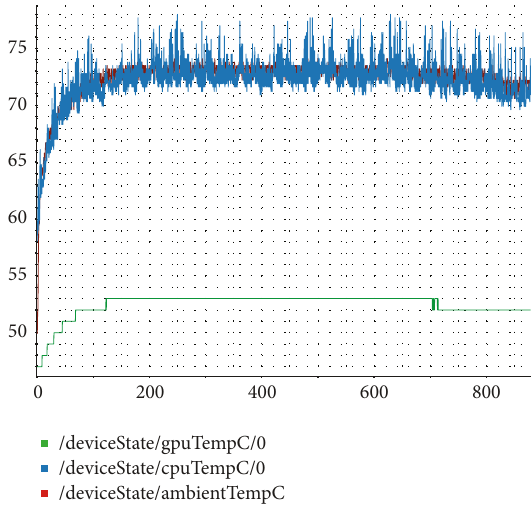
Figure 16: T1D3 temperatures.